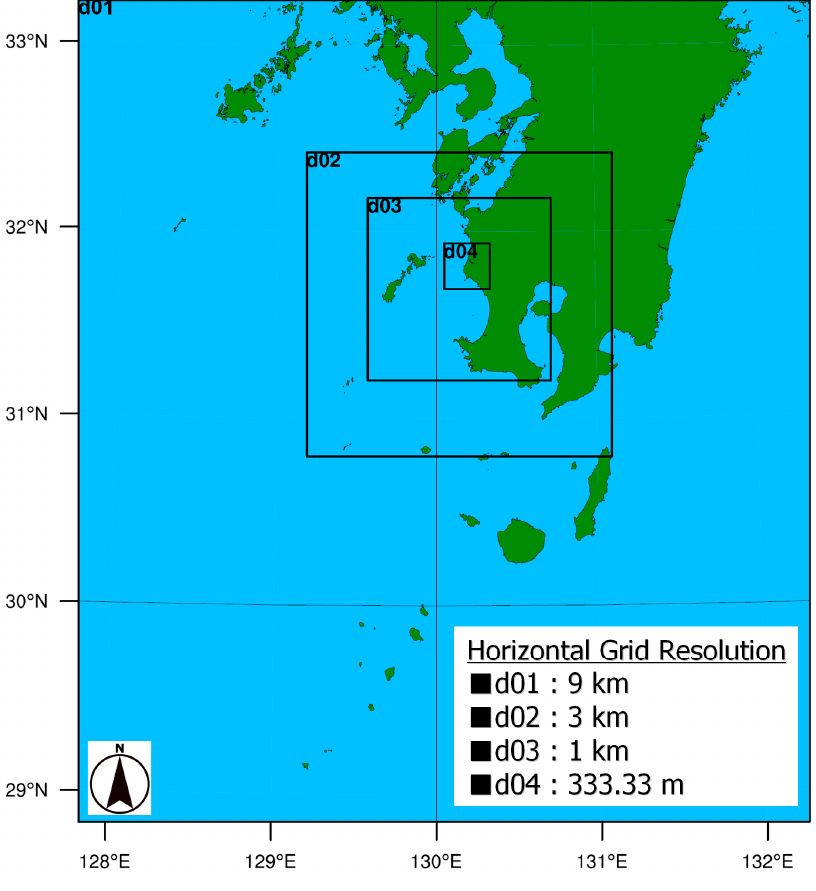
Figure 14. Computational domain used in the Weather Research and Forecasting (WRF) mesoscale model.